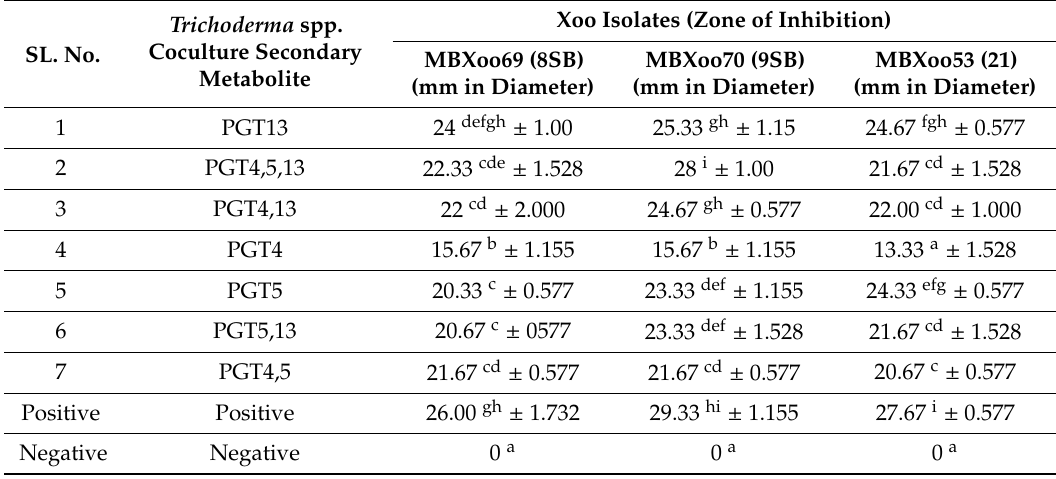
Figure 3. Screening of Trichoderma spp. co-culture secondary metabolites for its antibacterial activity against plant pathogen Xanthomonas oryzae pv. oryzae (Xoo); 8SB, 9SB and 21 represent strains MBXoo69, MBXoo70 and MBXoo53, respectively. Table 6. Antibacterial activity of Trichoderma spp. co-culture secondary metabolite against plant pathogen Xoo (Mean ± standard deviation).